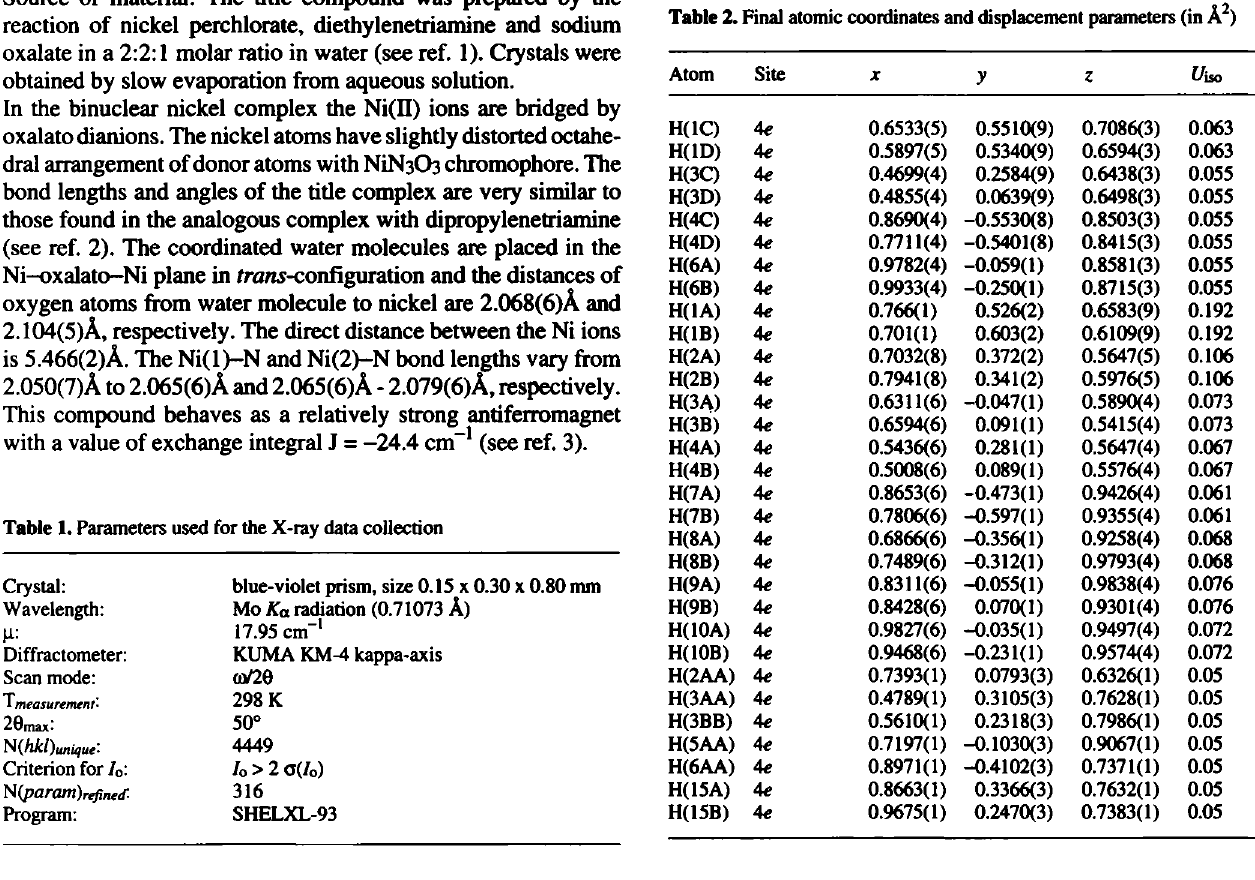
Table 2. Final atomic coordinates and displacement parameters (in Â 2